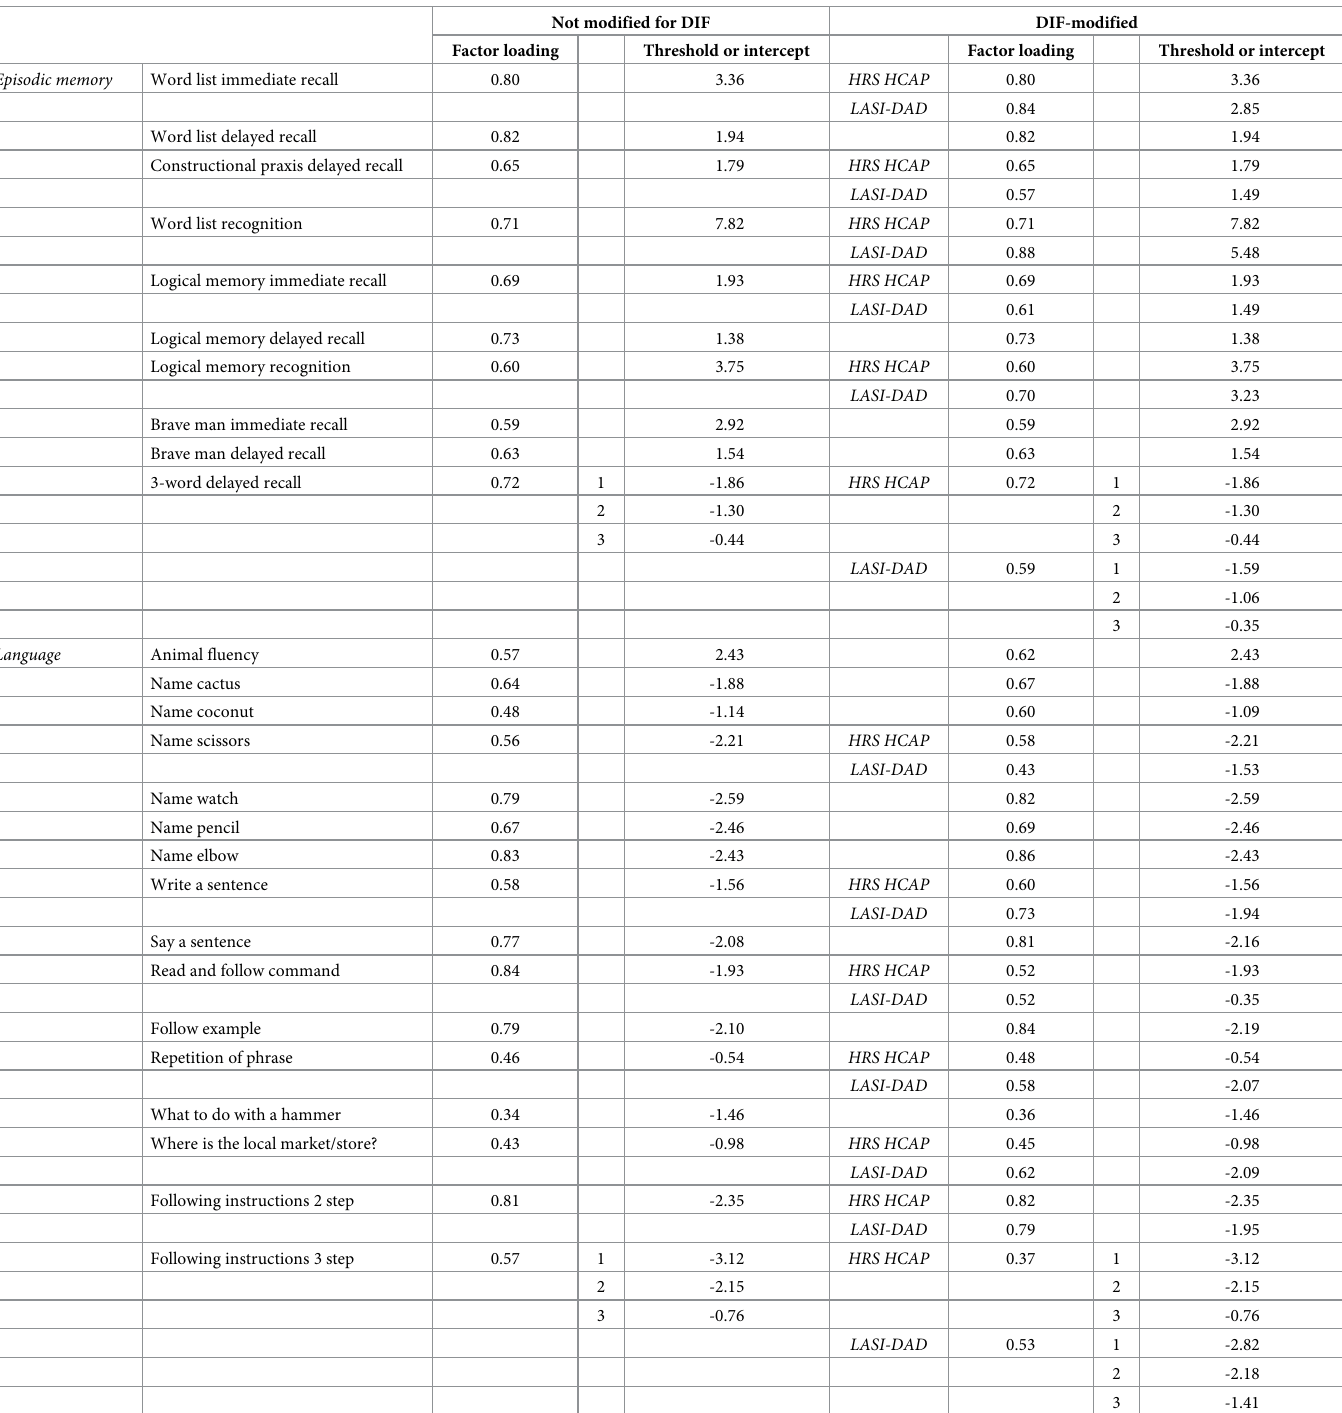
Table 3. Standardized factor loadings and thresholds or intercepts for episodic memory and language from the non-modified and DIF-modified CFA